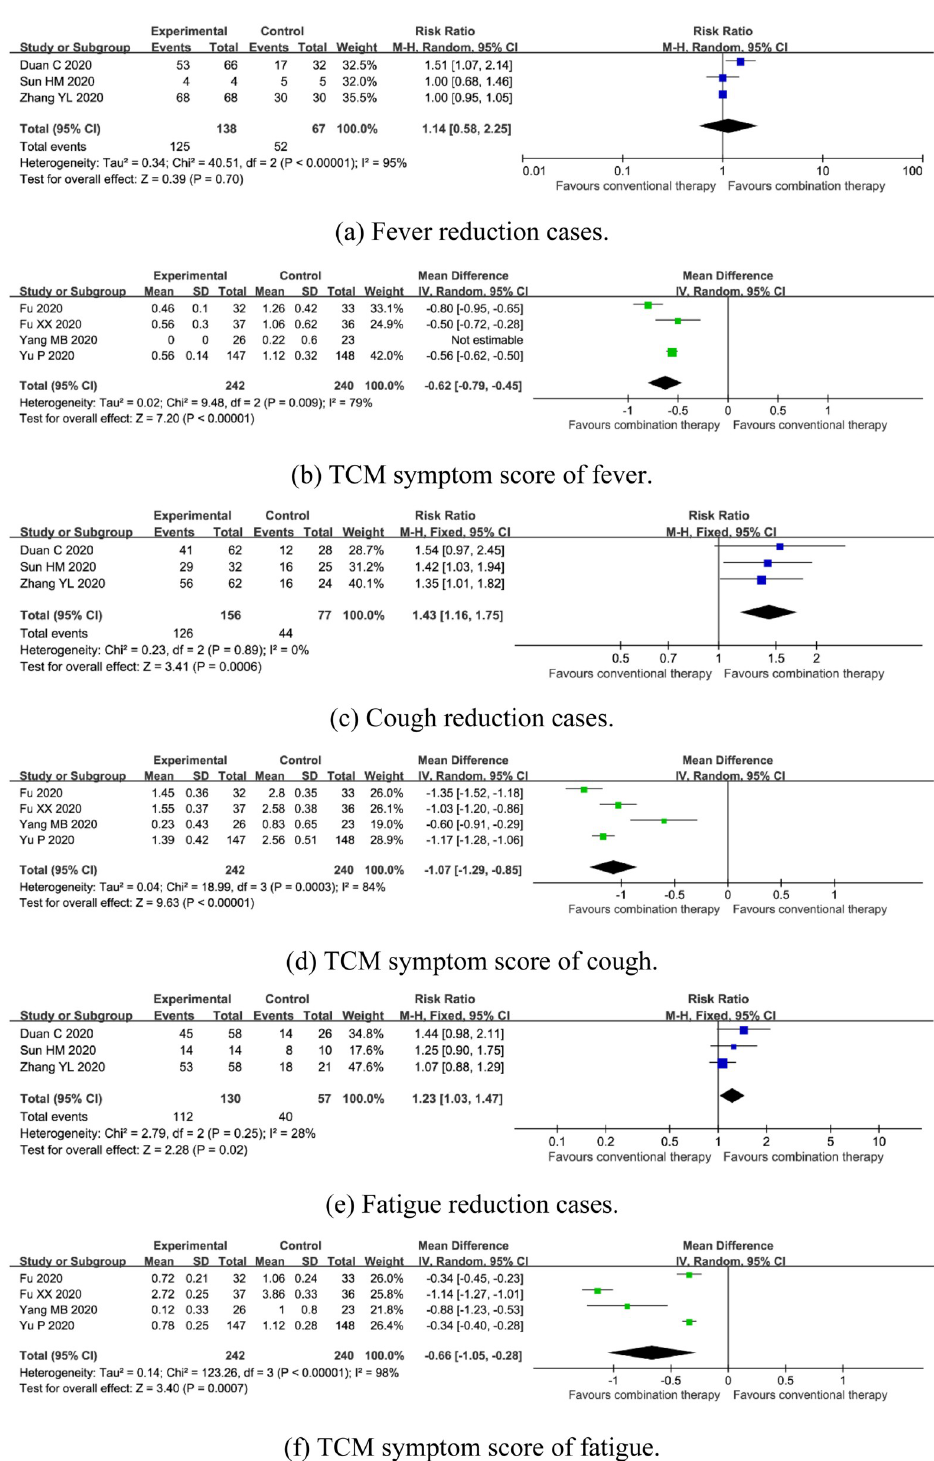
Fig 4. Forest plot of the effects of combination therapy for outcomes of (a) fever reduction cases, (b) TCM symptom score of fever, (c) cough reduction cases, (d) TCM symptom score of cough, (e) fatigue reduction cases, (f) TCM symptom score of